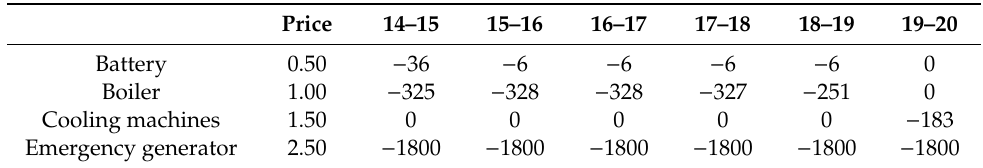
Table 11. Bids for iteration 3.